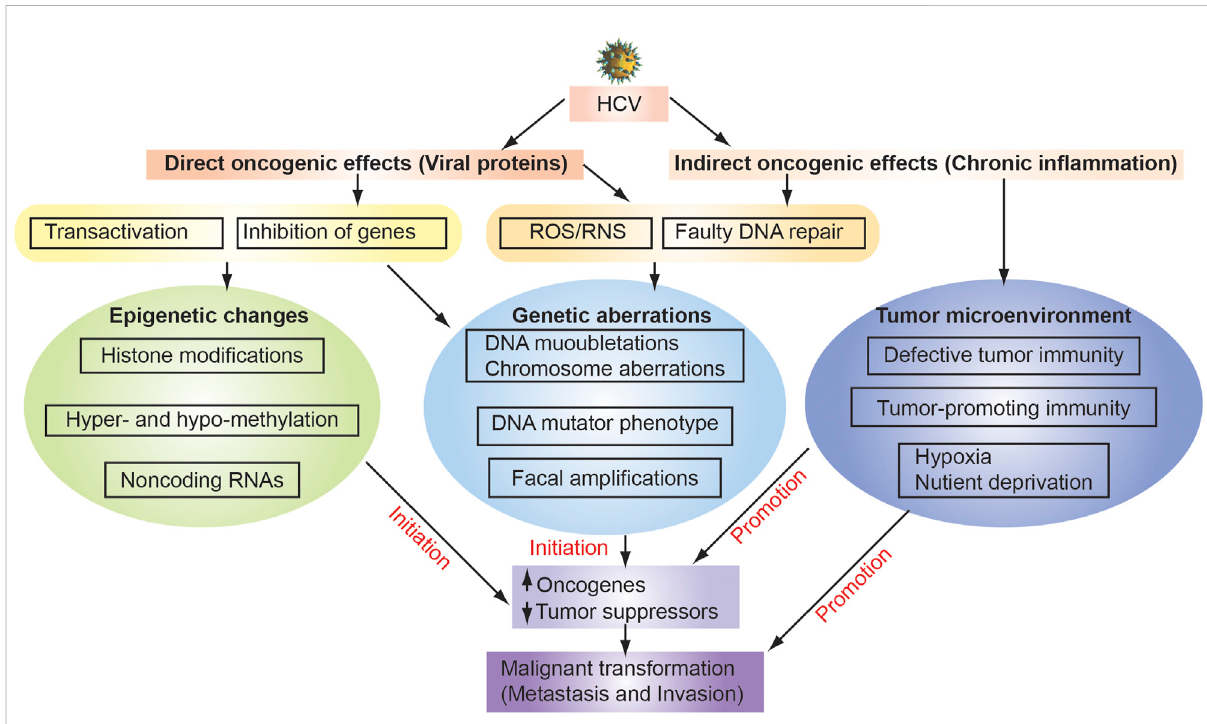
FIGURE 3 Mechanisms of HCV-associated hepatocarcinogenesis. HCV infection causes chronic in fl ammation in the liver as indirect oncogenic carcinogeniceffects,leadingtogeneticalterationthroughROSgeneration,elevatedexpressionofDNAmutatorphenotype,anddysfunctionofDNA repair.Asindirectoncogeniccarcinogeniceffectsinducetumormicroenvironmentwithdefectivetumorimmunity,tumor-promotingimmunityand hypocix and nutriet deprived environment. Environmental factors (e.g., Alcohol, obesity, and high fat diet) enhance sensitivity of livers to LPS. Direct effects of hepatitis virus, including the oncogenic effects of HBV genome integration and HBx protein expression, can also contribute to increased genomic instability. These multiple factors coordinately induce the accumulation of genetic and epigenetic alterations in liver tissue underlying chronic hepatitis or cirrhosis, leading to the development of